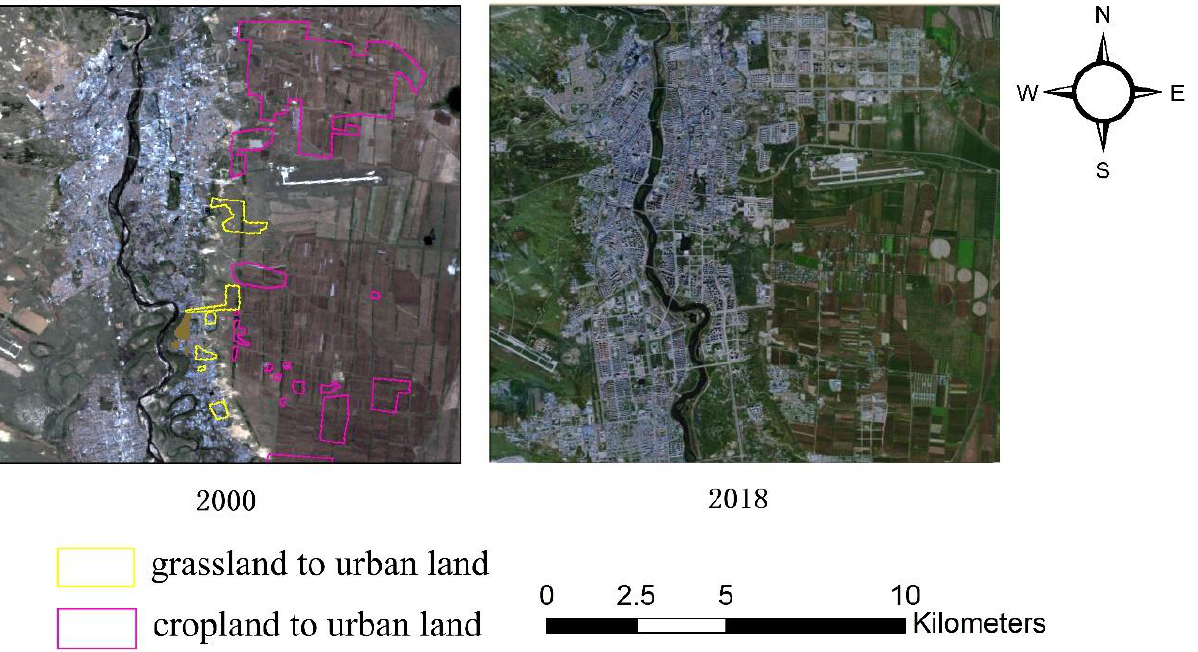
Figure 9. An exemplary area showing the comparison of the land cover change results and RGB ortho-mosaic images.